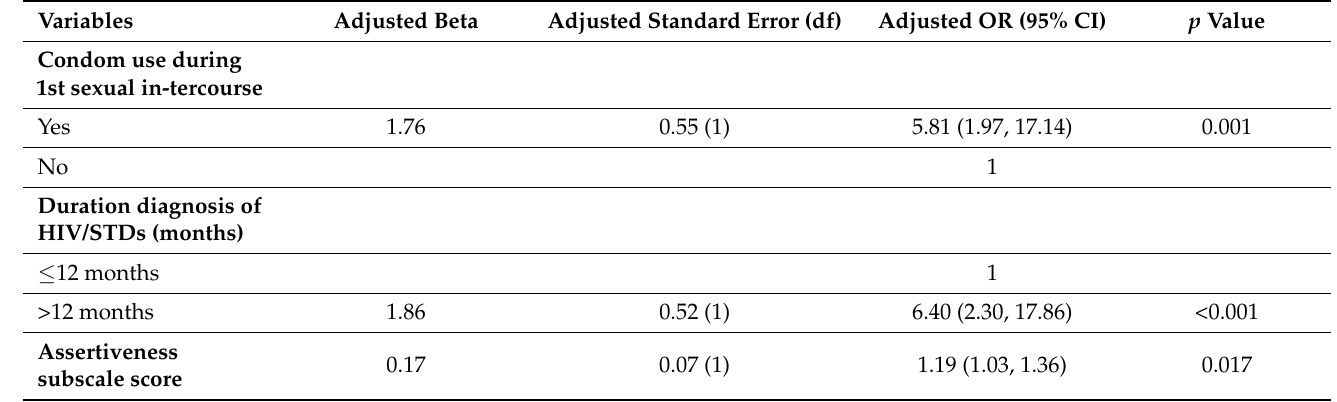
Table 5. Multiple logistic regression on factors associated with good condom